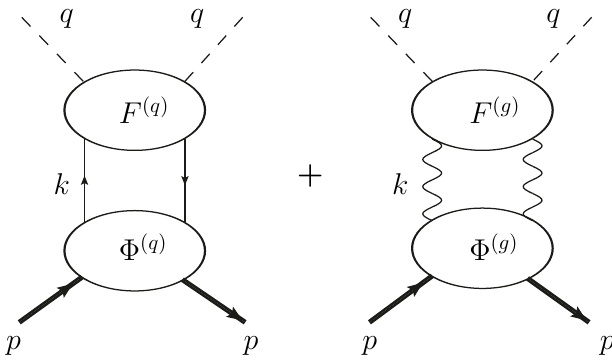
Figure 1 . QCD factorization for DIS structure functions. Dashed lines denote virtual photons. The upper blobs describe DIS off partons. The straight (waved) vertical lines denote virtual quarks (gluons). The lowest blobs correspond to initial parton distributions in the hadrons. F ( q,g ) is a generic notation for perturbative components of F ( q,g )